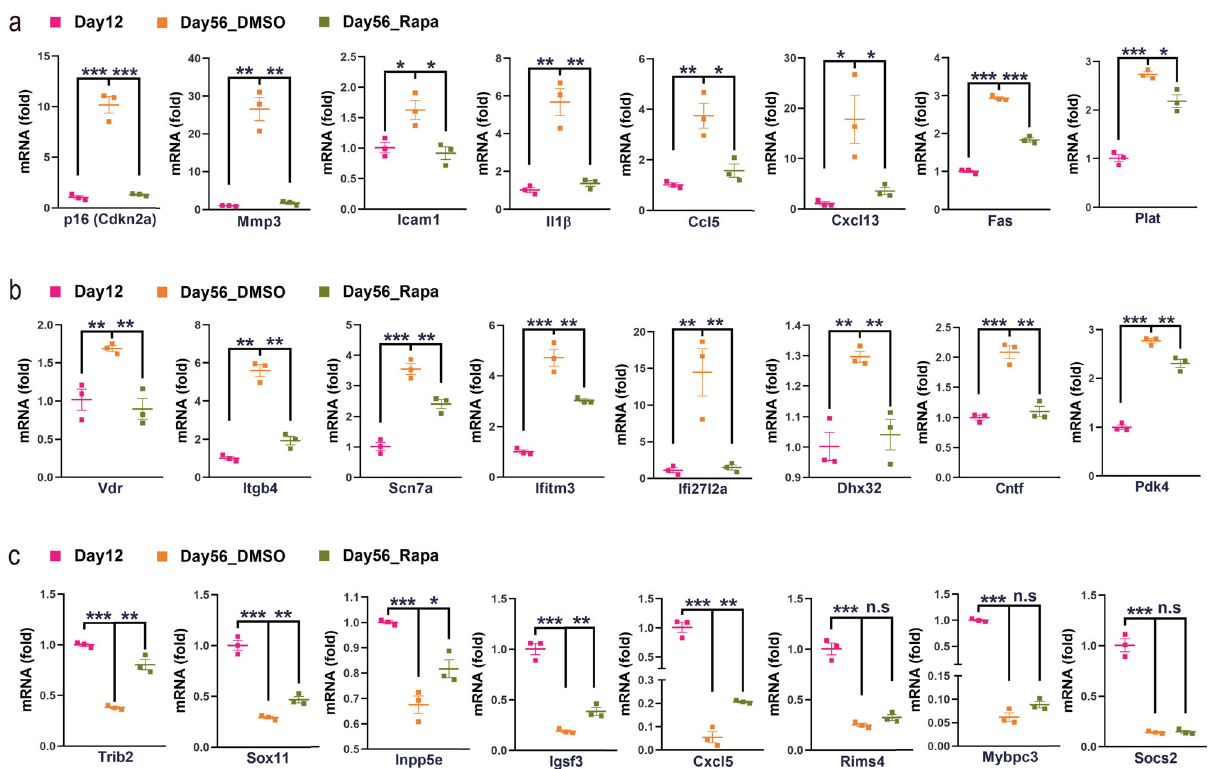
Fig. 2 Aging-regulatory effects of rapamycin in COCS. a Rapamycin (Rapa) decelerated the time-dependent upregulation of cellular senescence genes, including the senescence marker p16 (Cdkn2a) and members of the senescence-associated secretory phenotype. b, c Rapamycin (Rapa) decelerated the time-dependent upregulation ( b ) and downregulation ( c ) of eight and fi ve randomly picked age-predictive genes in COCS, respectively ( n = 3). Data are presented as mean ± SEM. * p < 0.05, ** p < 0.01, *** p < 0.001. n.s not signi fi